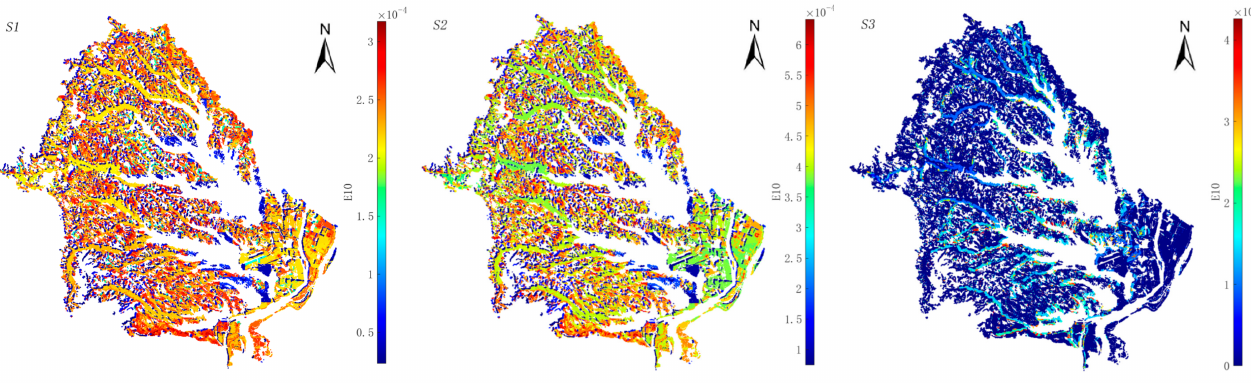
Figure 13. Spatial distribution of E10 under different scenarios. S1: halving fertilization every year; S2: fallow every other year; S3: returning agricultural land to